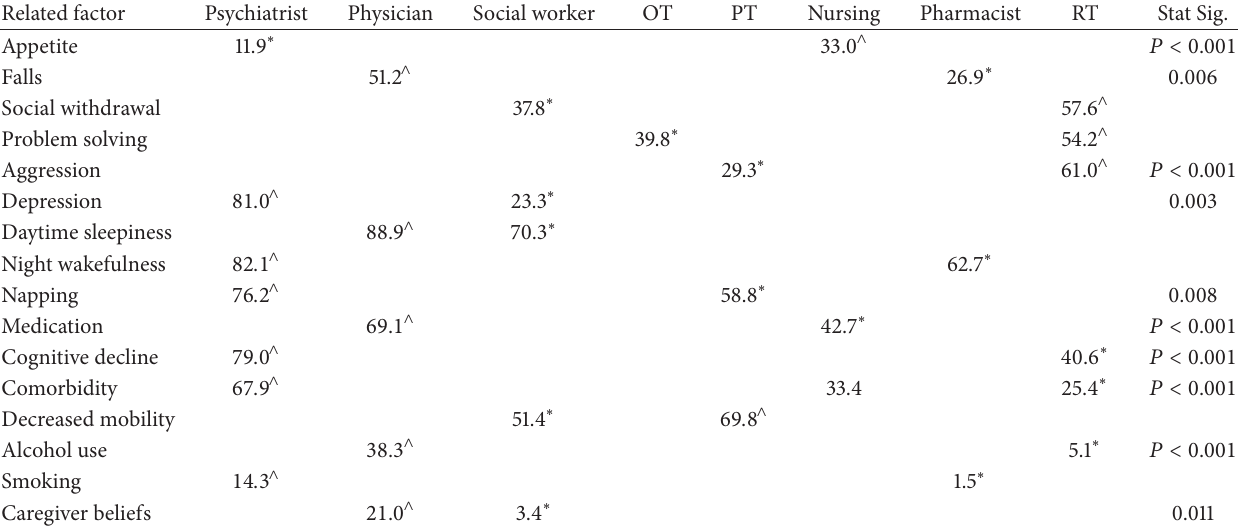
Table 2: Awareness of relationship between risk factors and disordered sleep (%).